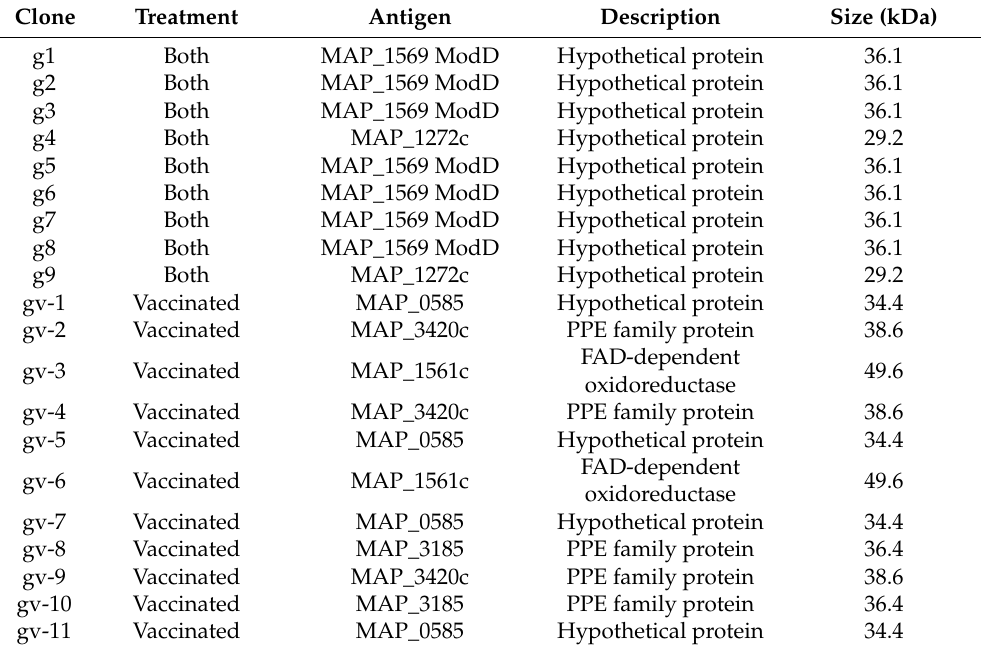
Table 2. Antigens identified from 20 expression library